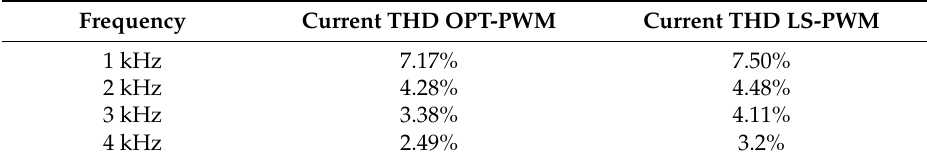
Table 4. Total Harmonic Distortion (THD) of the injected current at di ff erent frequencies for SPWM and OPT-PWM.